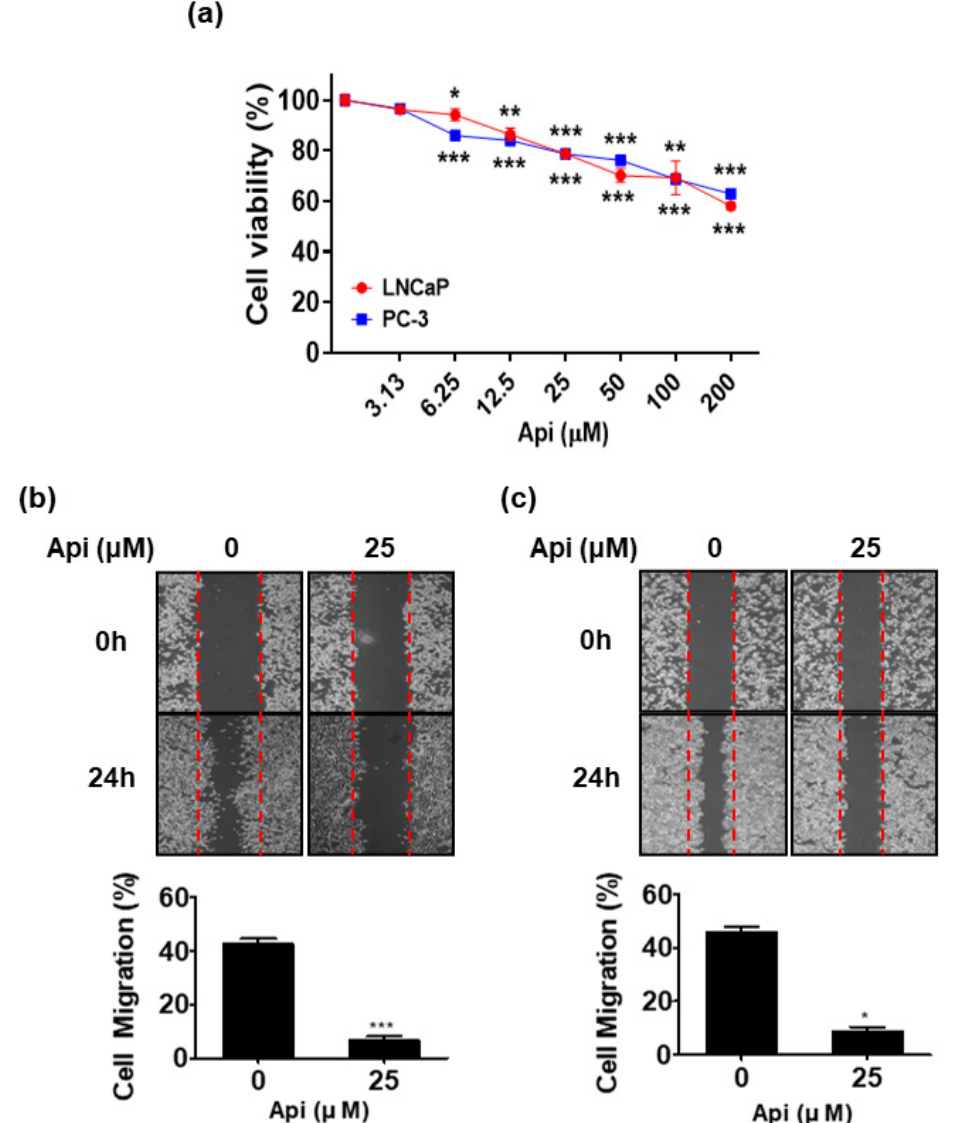
Figure 1. Effect of apigetrin on cell cytotoxicity and migration in LNCaP and PC-3 cells. ( a ) LNCaP and PC-3 cells were treated with the indicated concentrations of apigetrin for 24 h (n = 3). CELLOMAX TM Kit based on WST-8 assay was used to measure cell viability. Results are presented as the means ± SD of three independent experiments. * p < 0.05, ** p < 0.01, and *** p < 0.001 versus control groups. LNCaP ( b ) and PC-3 ( c ) cells were treated with apigetrin (25 µ M) for 24 h, and cell migration was assayed by wound healing assay (n = 3). The number of cells migrating into the scratched area was photographed ( × 100) and calculated as a migration percentage. The bar graph represents the proliferation percentage. * p < 0.05 and *** p < 0.001 (in compared to untreated